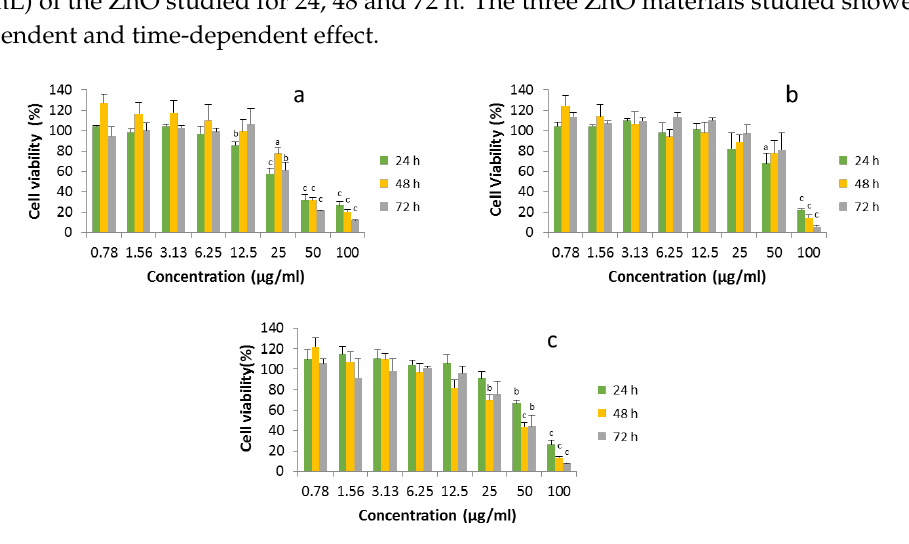
Figure 1. Transmission electron microscopy (TEM) images of ZnO 50 nm ( a ) and 100 nm ( b ) in distilled water, phosphate buffered saline (PBS) and Dulbecco’s modified Eagle medium (DMEM) cell